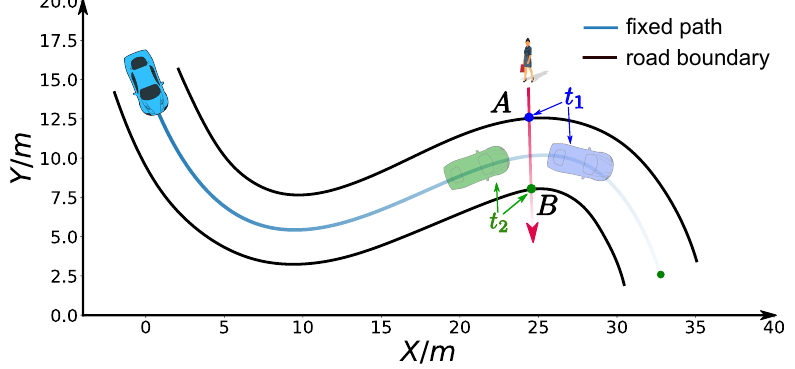
Figure 18. Jaywalking scenario.